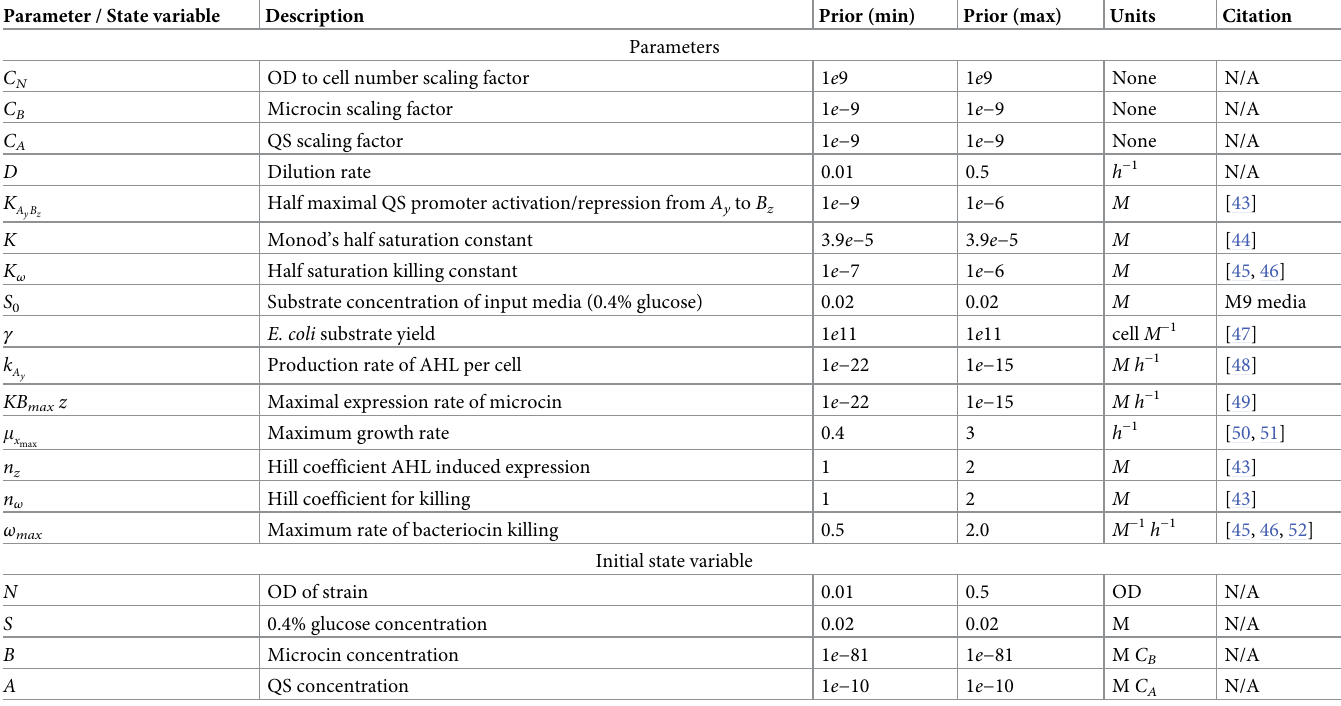
Table 1. Prior distributions for both two and three strain systems are sampled uniformly between the min and max values listed below. Constant parameters have the same min and max value. Parameter / State